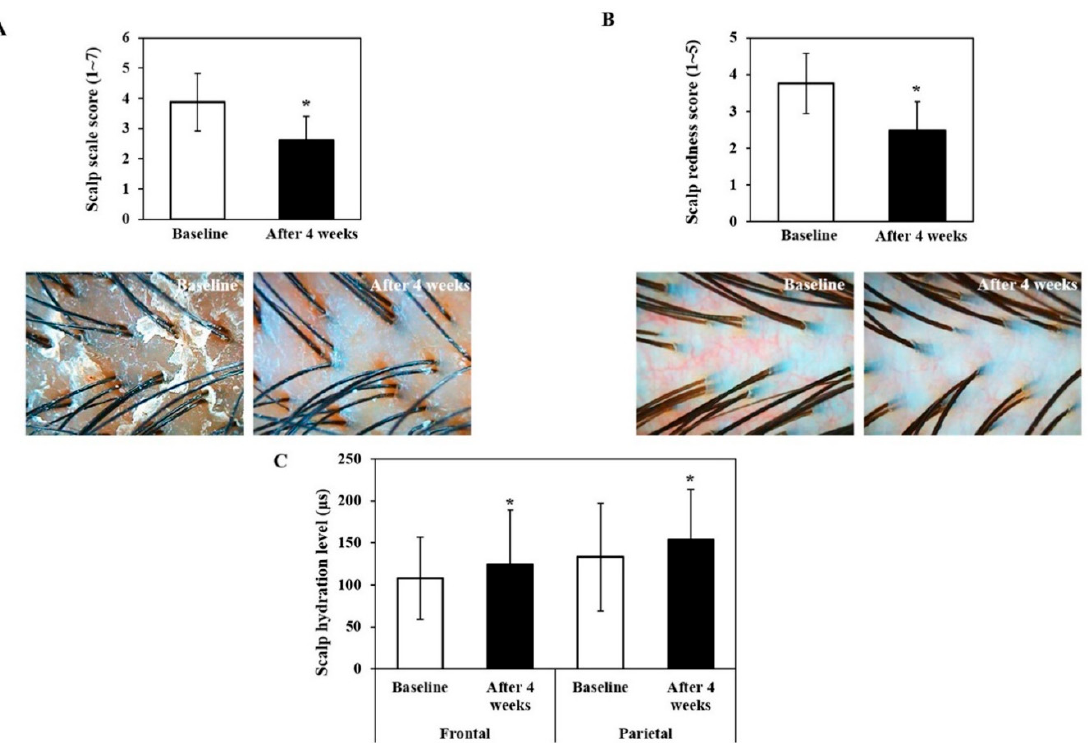
Figure 4. Clinical study using 0.02% E. cava extract containing shampoo. Female volunteers used E. cava extract containing shampoo for 4 weeks to reveal its protective effect on human scalp. The scalp scale and redness were photographed using Aroma TS ® and assessed by two qualified researchers according to standard criterion ( A , B ). The skin hydration on frontal and parietal region was measured by conductance measurement ( C ). Statistical analysis of the clinical test was conducted using the SPSS (R) software program (IBM, USA).